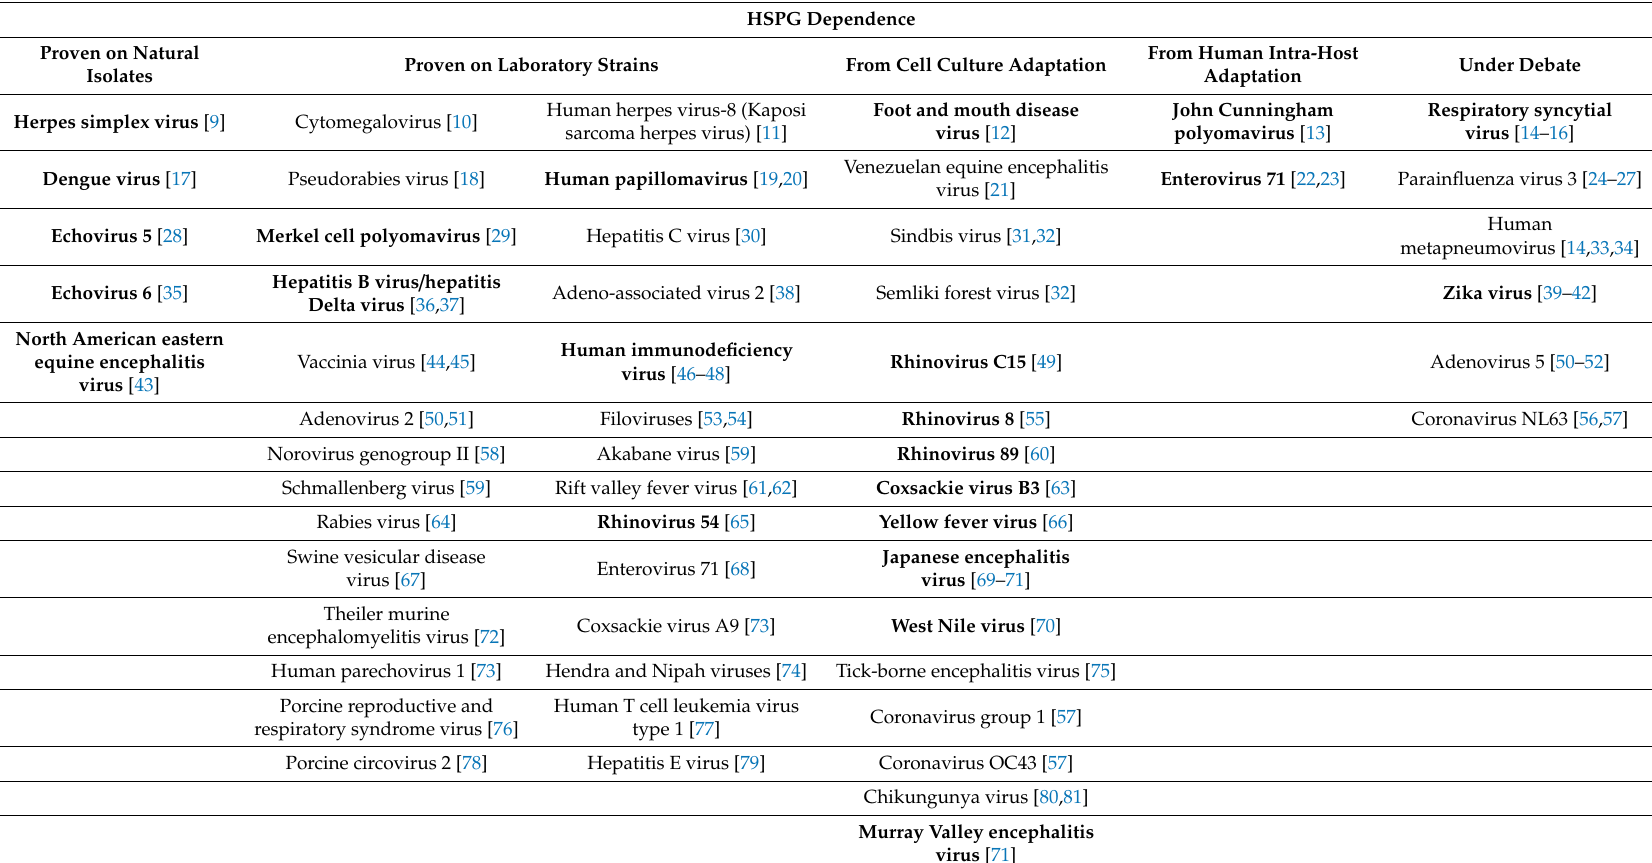
Table 1. Classification of viruses according to their HSPG